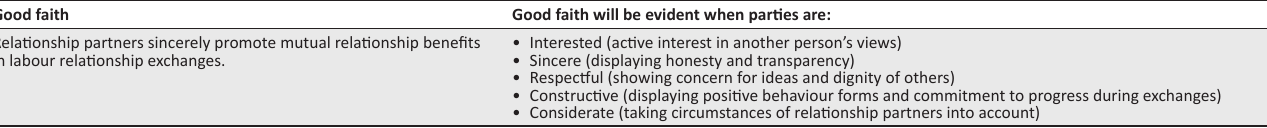
TABLE 4: Criteria for assessing good faith in labour relationships. Good